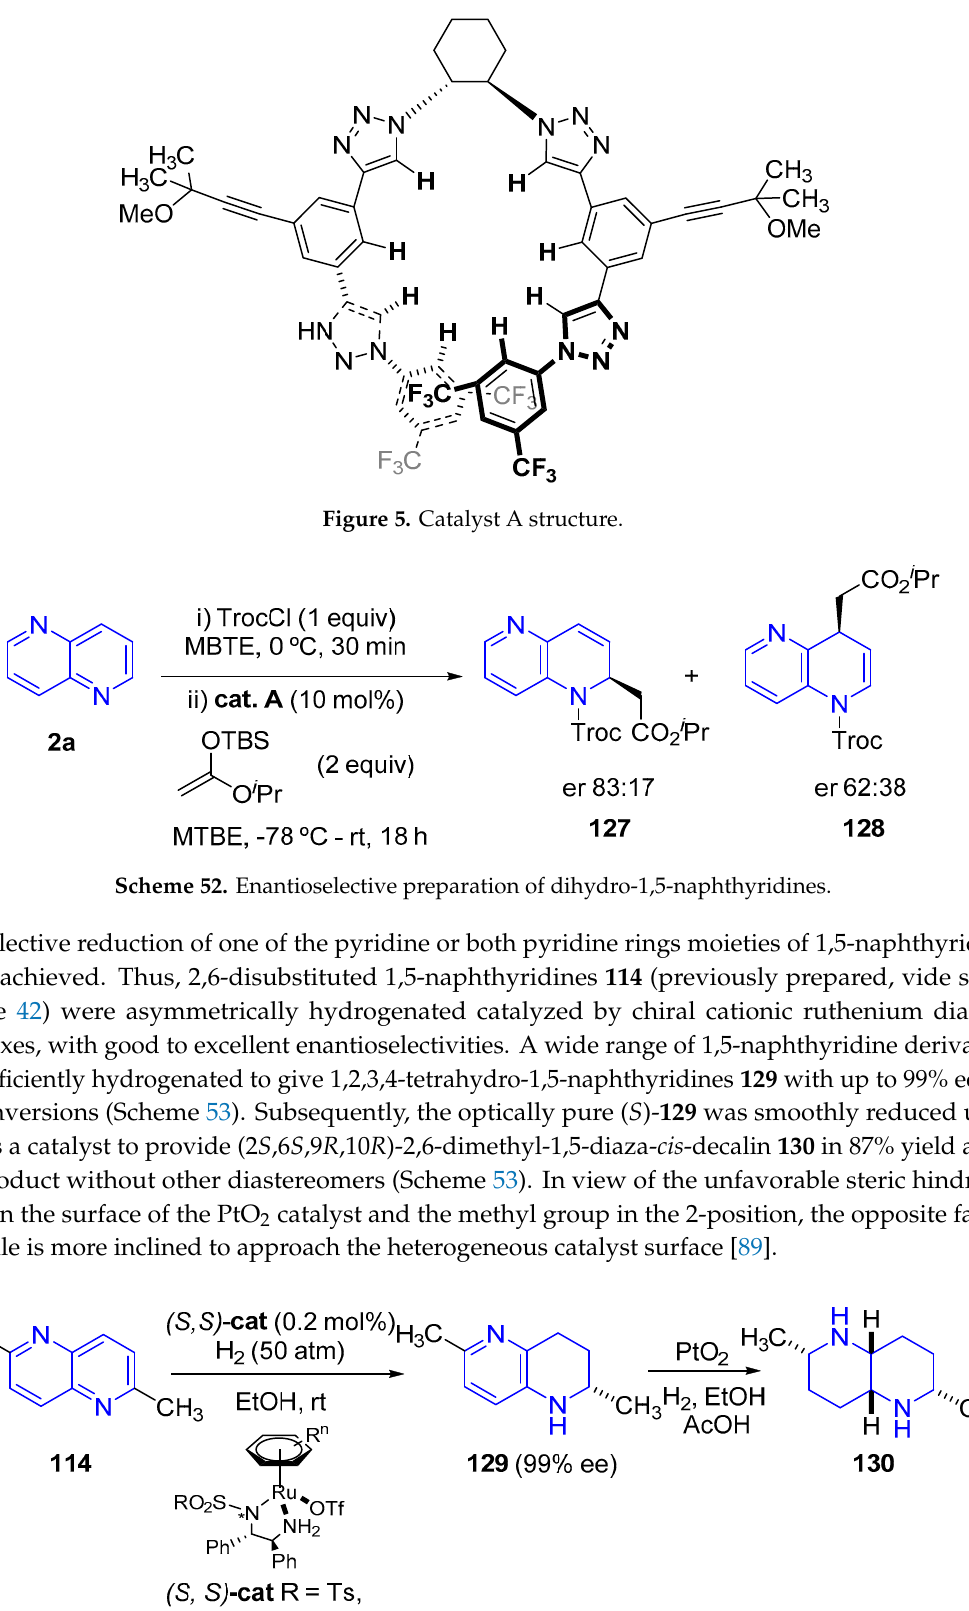
Figure 5. Catalyst A structure.